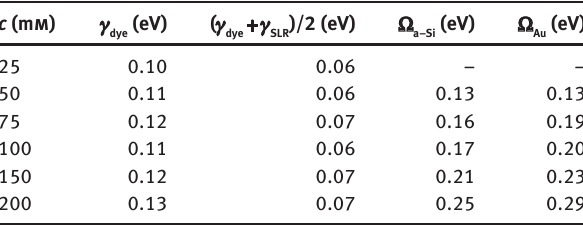
The molecule linewidth is obtained by fitting two Gaussians to the measured absorption spectrum (see Figure 1) and choosing the underlying Gaussian for the main absorption peak.